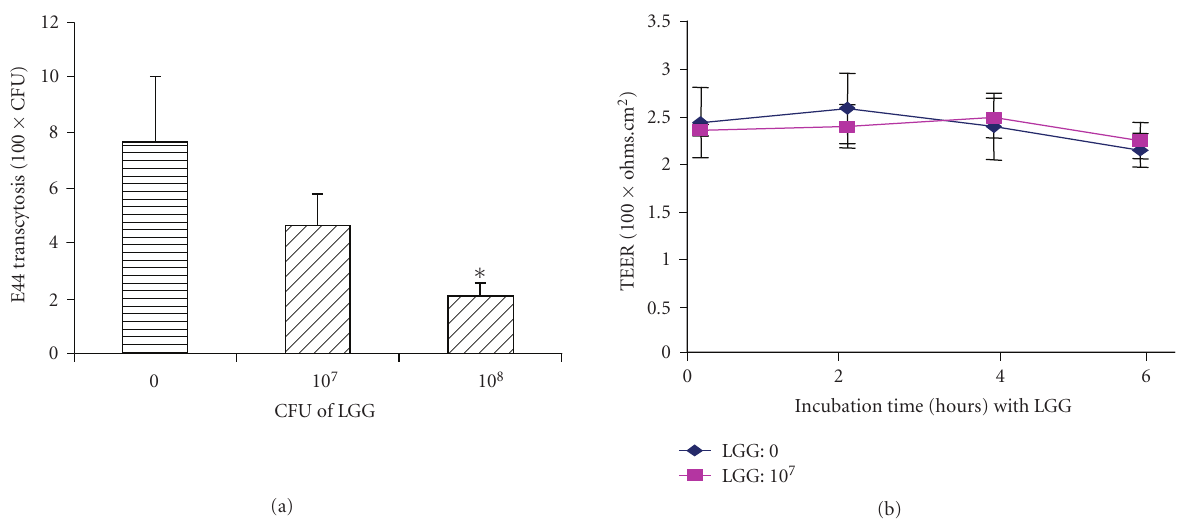
Figure 2: E ff ects of LGG on E. coli K1 translocation across Caco-2 monolayers (a) and transepithelial electrical resistance (TEER) of Caco-2 monolayers (b). (a) Epithelial cells were incubated with various doses of L. rhamnosus for 3 hours before adding 10 7 E44. Transcytosis assays were carried out as described above. All values represent the means of triplicate determinations at 4 hours. Experiments were repeated three times. Error bars indicate standard deviations. ∗ P < . 05. (b) TEER was not significantly altered after 0 to 6 hours incubation.